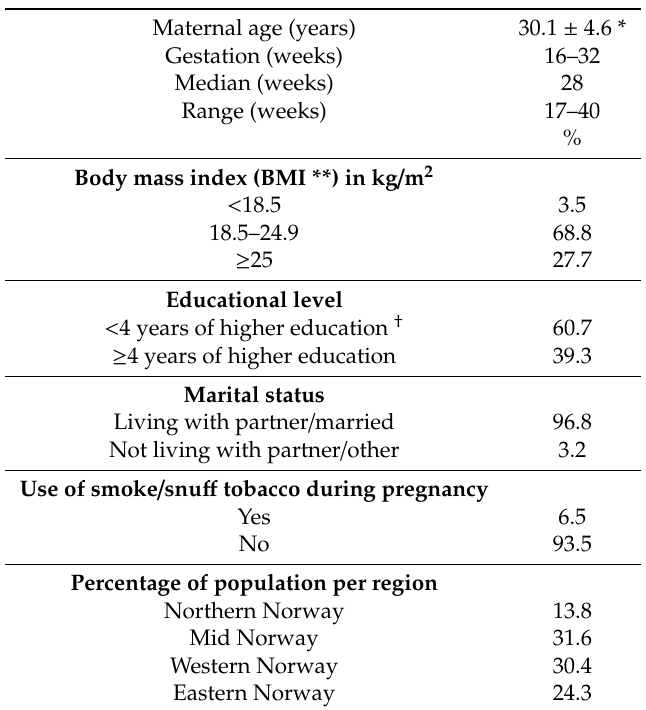
Table 1. Background characteristics of the population.